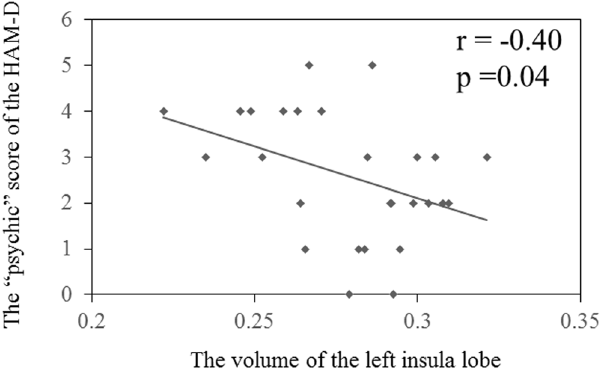
Figure 2. Relationship between the “psychic (items 9 and 10)” score of the HAM-D and the volume of the left insula lobe. The higher “psychic (items 9 and 10)” score of the HAM-D is associated with the volume reduction of the left insula lobe (Spearman rank correlation: uncorrected-p = 0.04, R = −